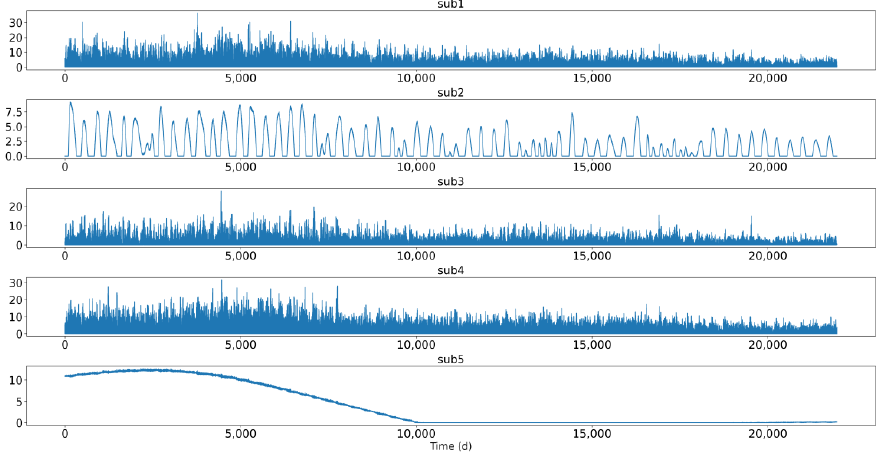
Figure 16. The five subfigures represent five subsequences which are generated through decomposition and dimension reduction from the original time series in case 4. After integration, the white noise test showed the residual series was not noisy. The values are shown in Figure 17.